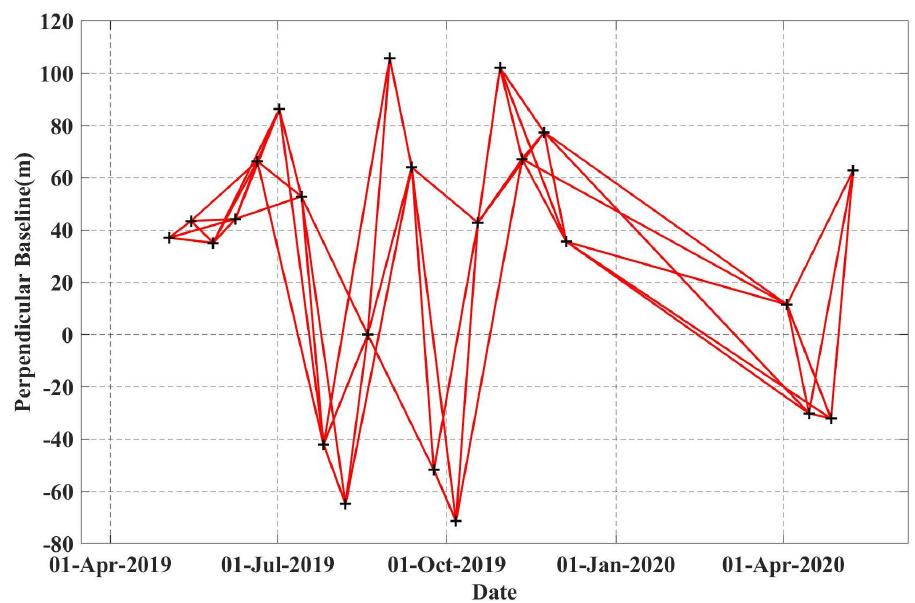
Figure 2. Temporal and perpendicular baseline distribution of the acquisitions used in this study. Plus symbols represent the acquisitions and red lines denote the interferometric pairs used to form interferograms. The perpendicular baseline was set to be within 150 m, and the maximum temporal baseline was 144